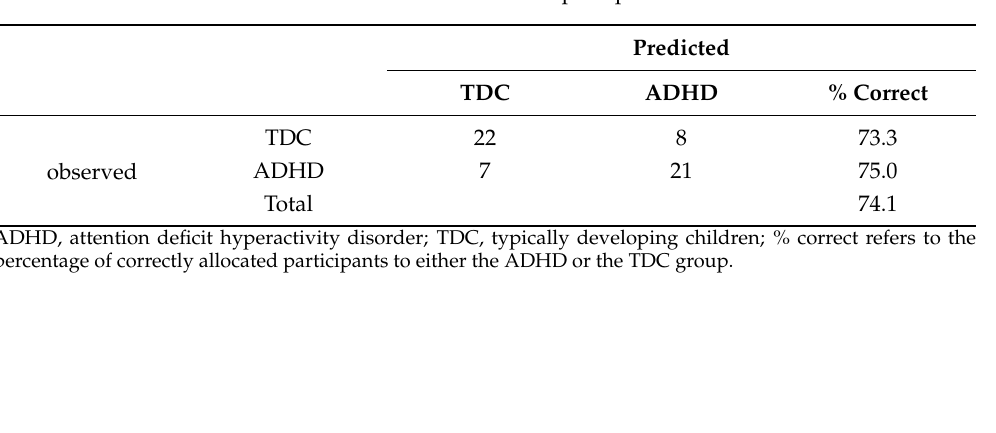
Table 2. Binary logistic regression.